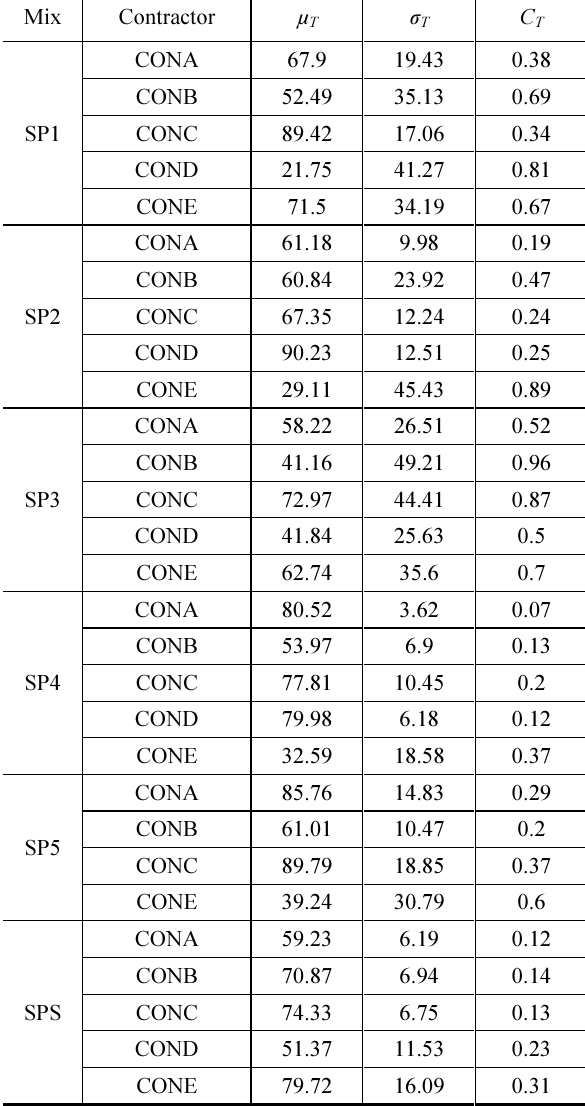
Table 2. Simulation output